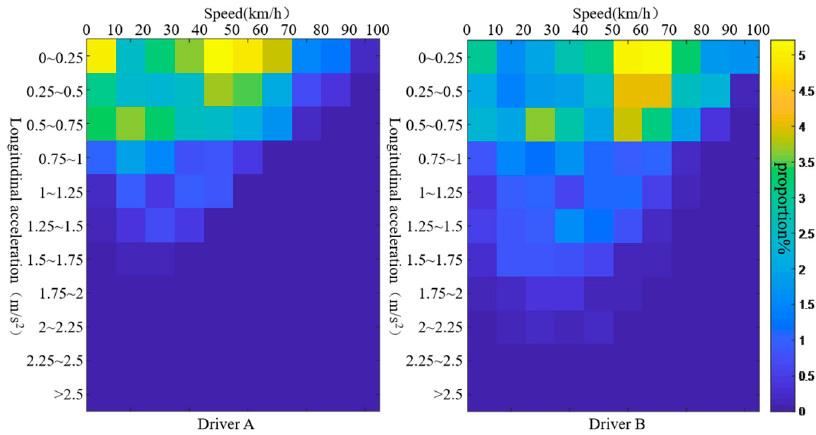
Figure 3. Joint distribution characteristics of vehicle speed and longitudinal acceleration.